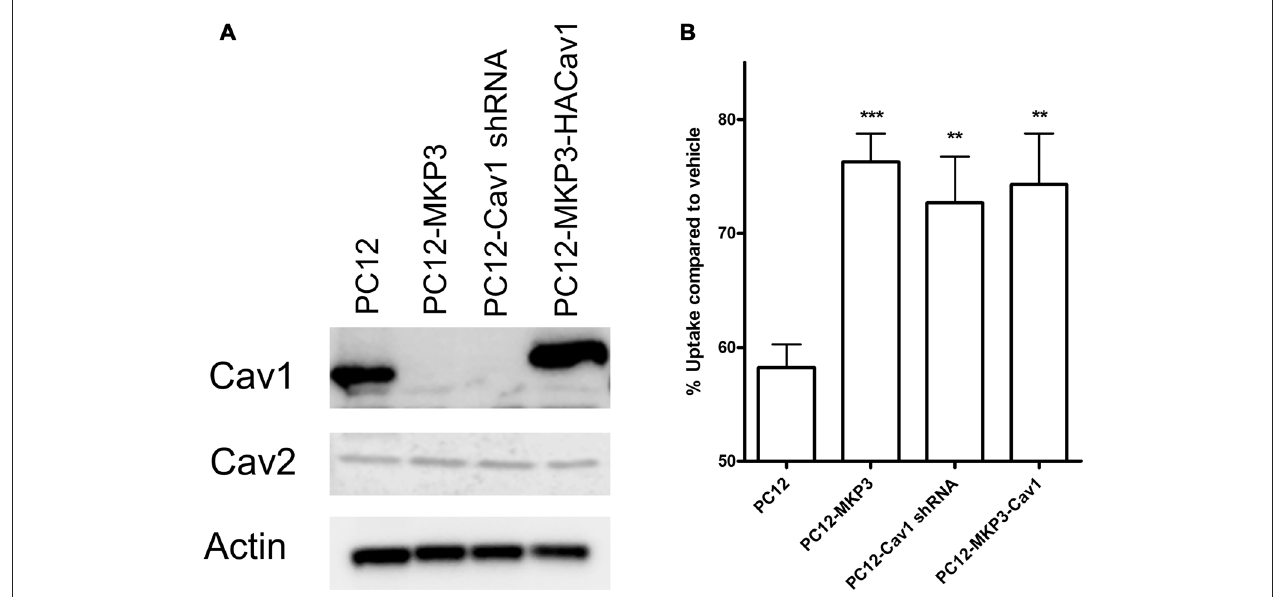
FIGURE 7 | Knockdown of caveolin-1 attenuates PKC-mediated down regulation of NET function. Immunoblotting demonstrate silencing of caveolin-1 expression by stable expression of Cav1 shRNA construct (PC12-Cav1 shRNA) or MKP3 (PC12-MKP3) and successful re-introduction of caveolin-1 in MKP3 expressing cells (PC12-MKP3-HACav1) (A) . Following Cav1 silencing or re-introduction PKC was activated by PMA for 30 min and NET-specific radiolabeled uptake was performed as above (B) . Results are displayed as percentage uptake following PMA treatment compared to vehicle treated control of respective cell type. Expression of MKP3 or silencing of Caveolin1 by the shRNA construct attenuates NET downregulation following PKC activation to a similar degree (B) . Re-introduction of caveolin1 into MKP3 expressing PC12 cells does not recover the PKC-mediated down regulation (B) . All experiments were performed in triplicate in three independent experiments. Results from three independent experiments were analyzed by two-way ANOVA with Bonferroni post hoc analysis ( ∗∗ p < 0.01, ∗∗∗ p < 0.001 comparing effects of PMA treatment. There was no significant difference in effect of PMA between MKP3 and MKP3-Cav1